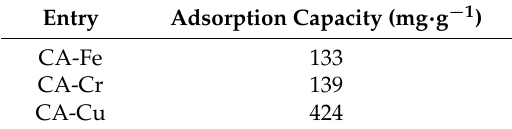
Figure 3. Adsorption isotherm of CA-X. Table 1. The adsorption capacity of CA-X.